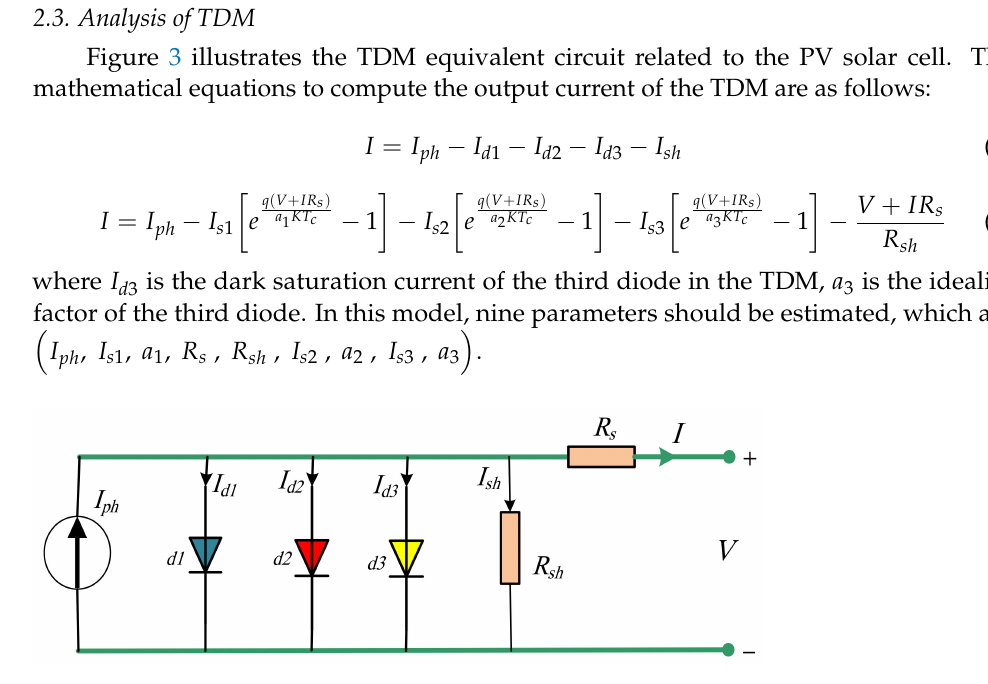
Figure 3. Three diode model (TDM) equivalent